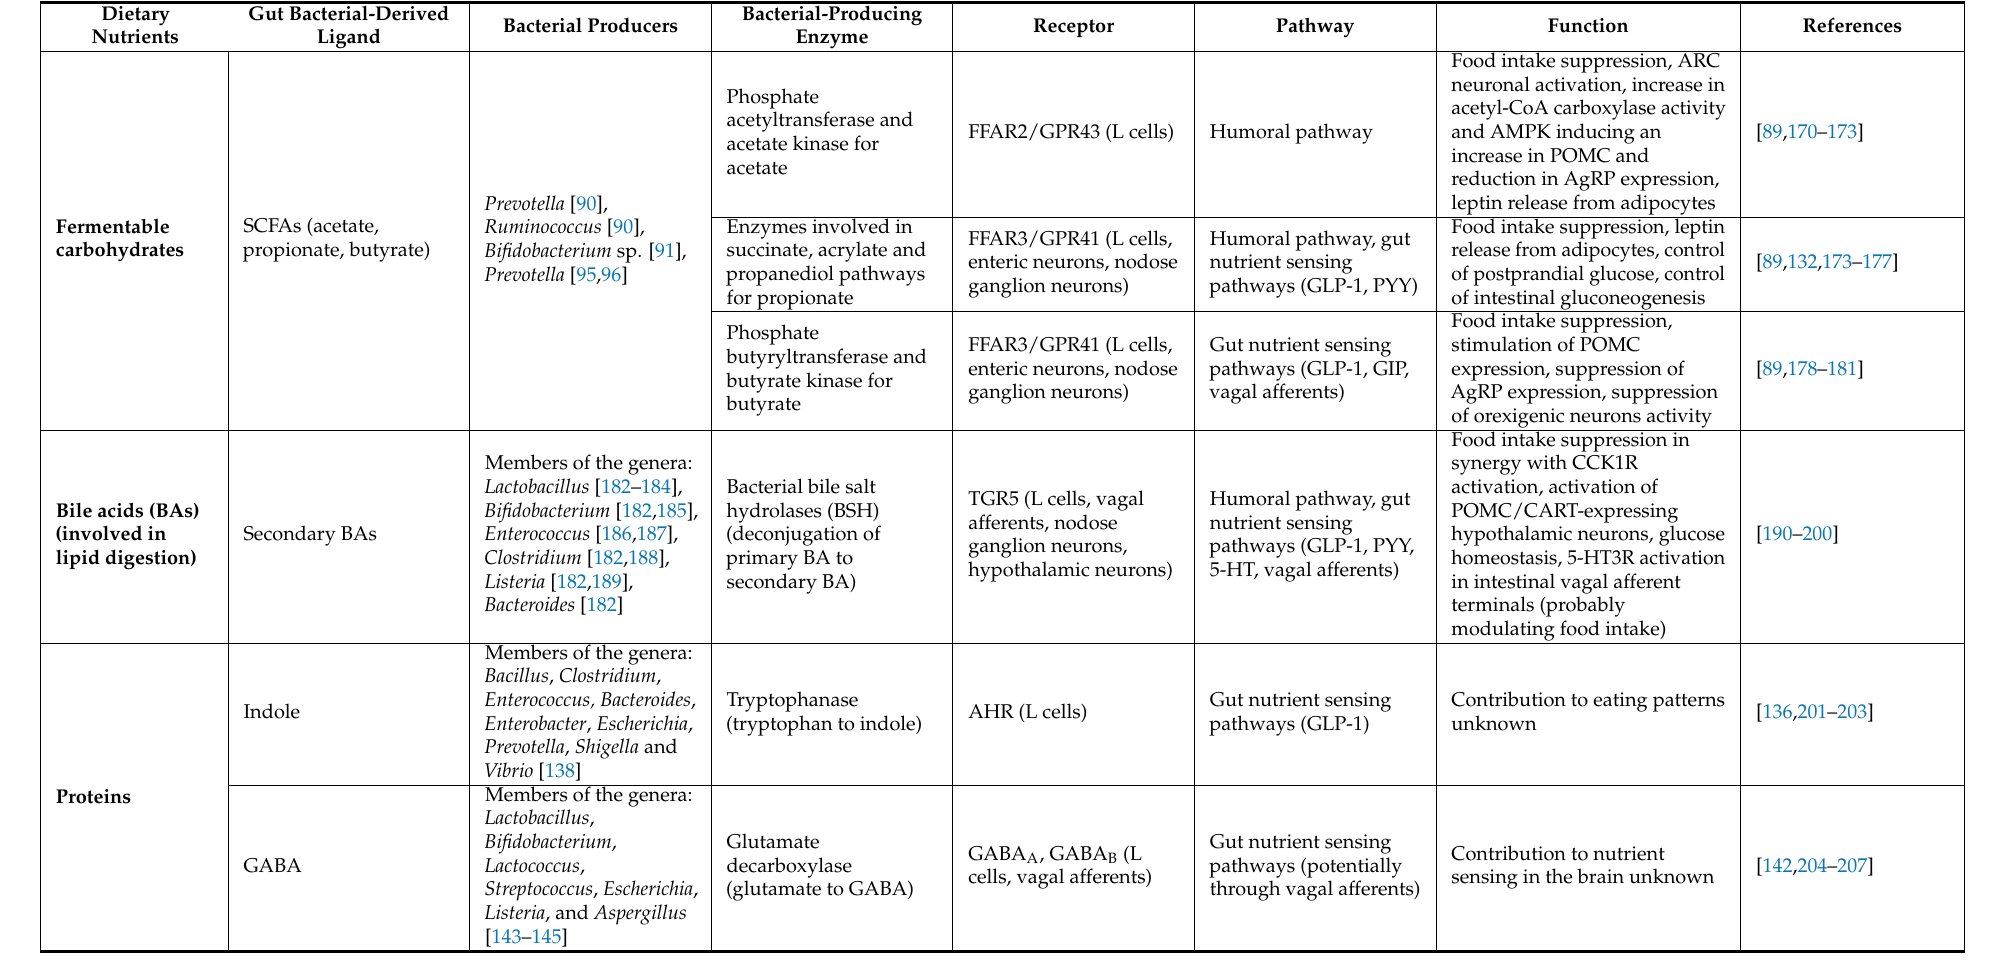
Table 1. Main microbially derived ligands of dietary and non-dietary nature involved in gut-to brain nutrient sensing and control energy homeostasis. Dietary